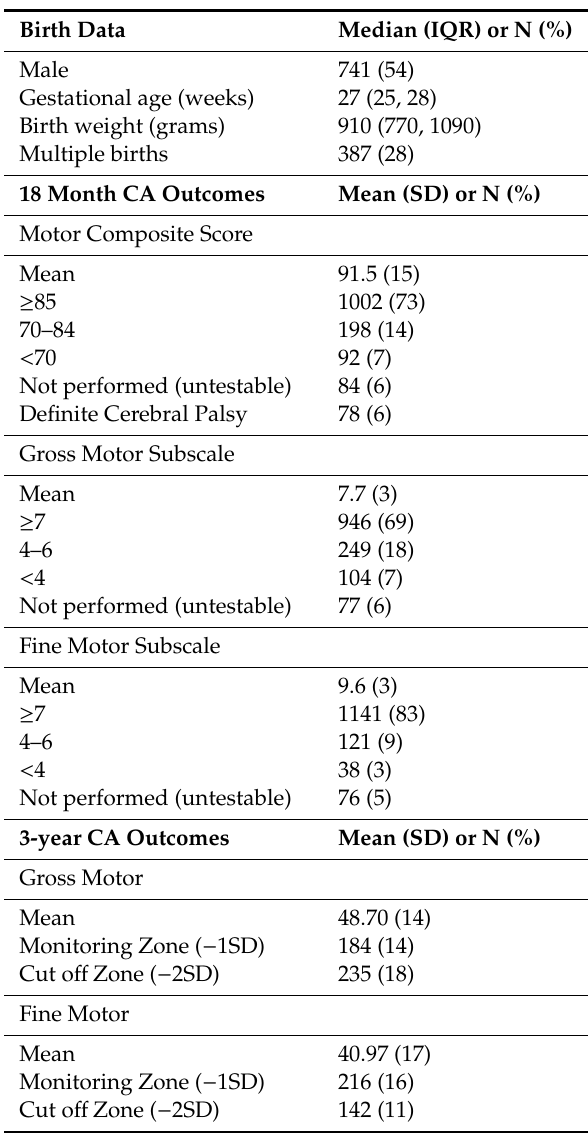
Table 1. Clinical